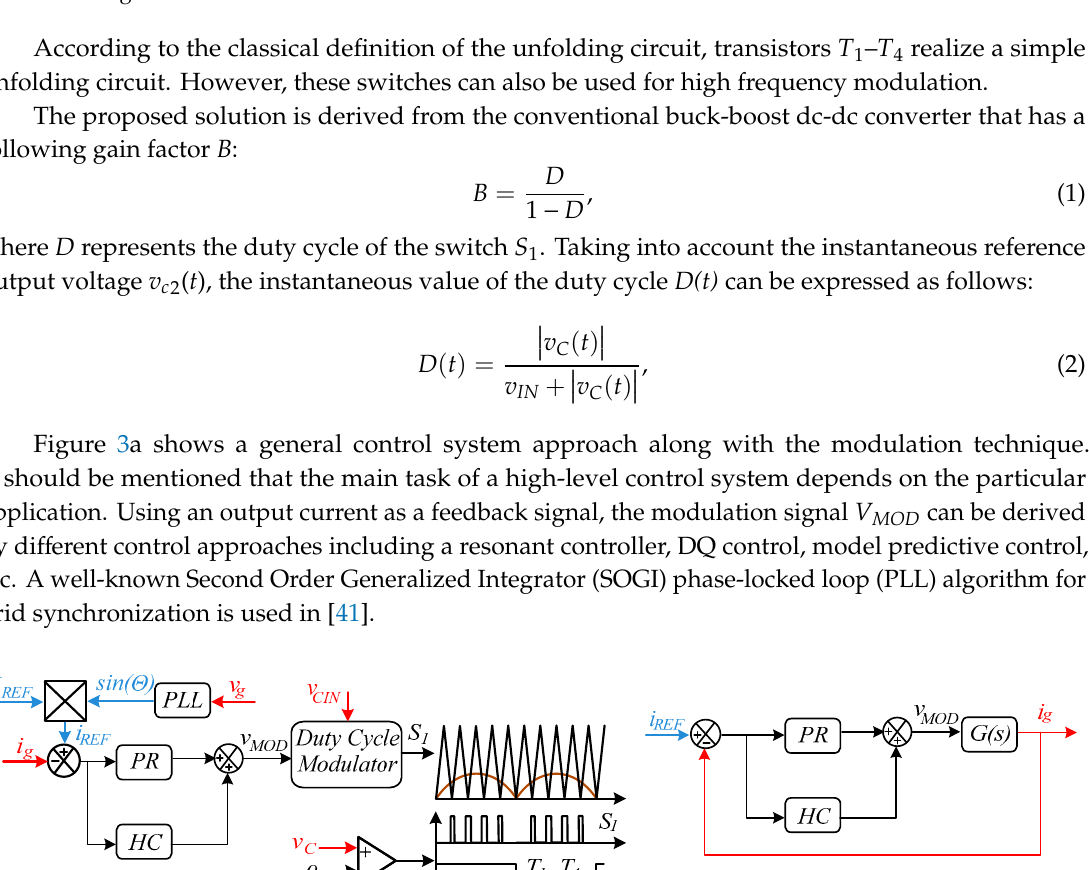
Figure 2. Single-phase twisted single-stage bidirectional buck-boost dc-ac converter based on unfolding circuit.